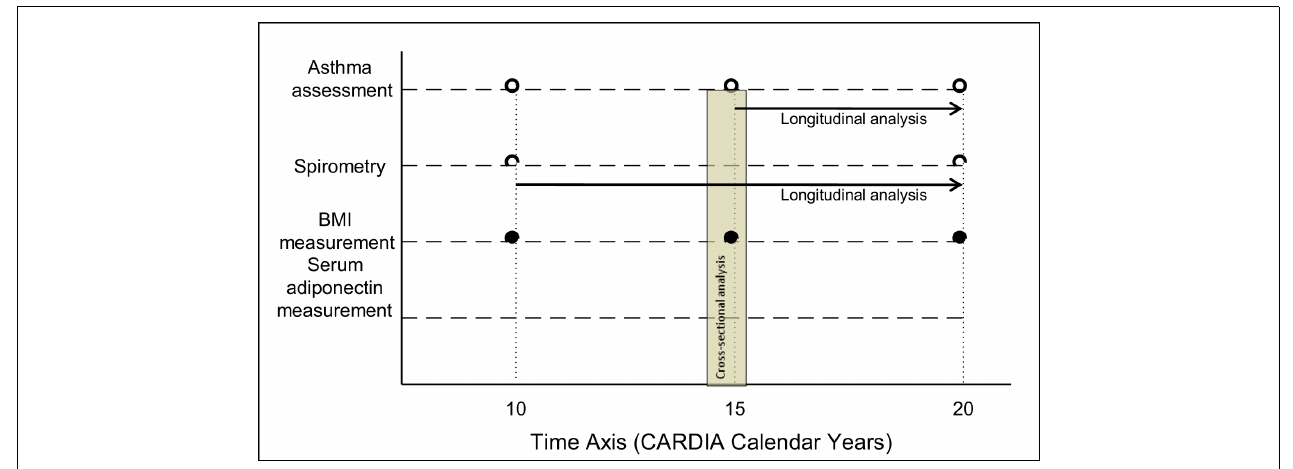
FIGURE 2 | Selected time axis for measurement of various outcome and predictor variables in the CARDIA